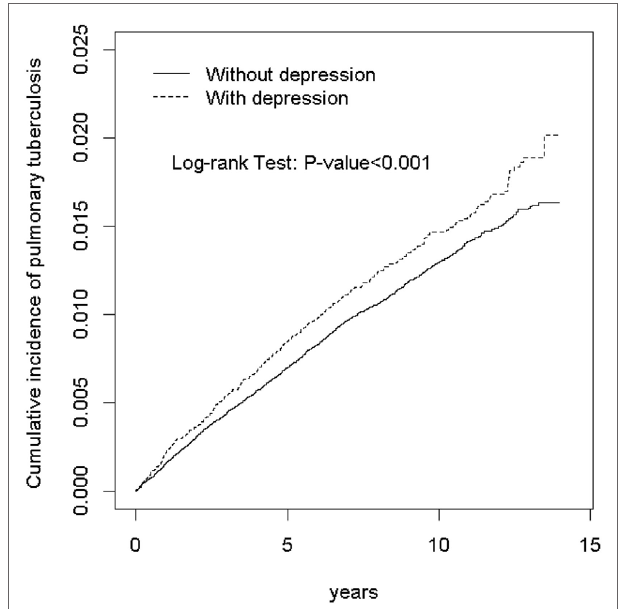
FigUre 1 | Kaplan–Meier model disclosed that the depression group had a higher cumulative incidence of pulmonary tuberculosis than the non- depression group (1.68 vs. 1.50% at the end of follow-up; P <